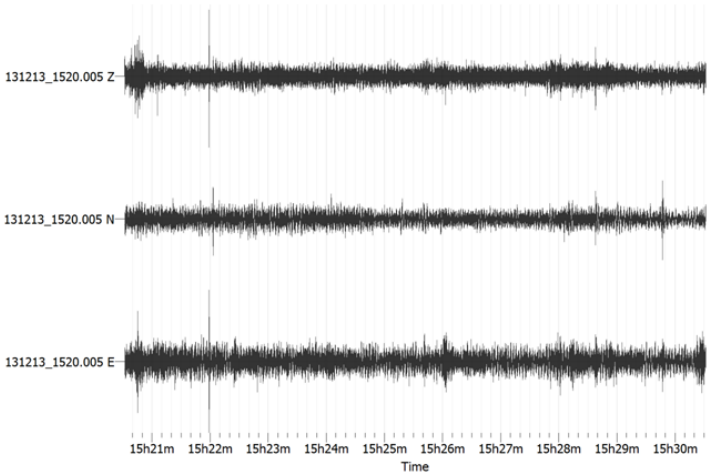
Figure 7. 10min recording of ambient noise on the second floor of the new building of TEI Chania.